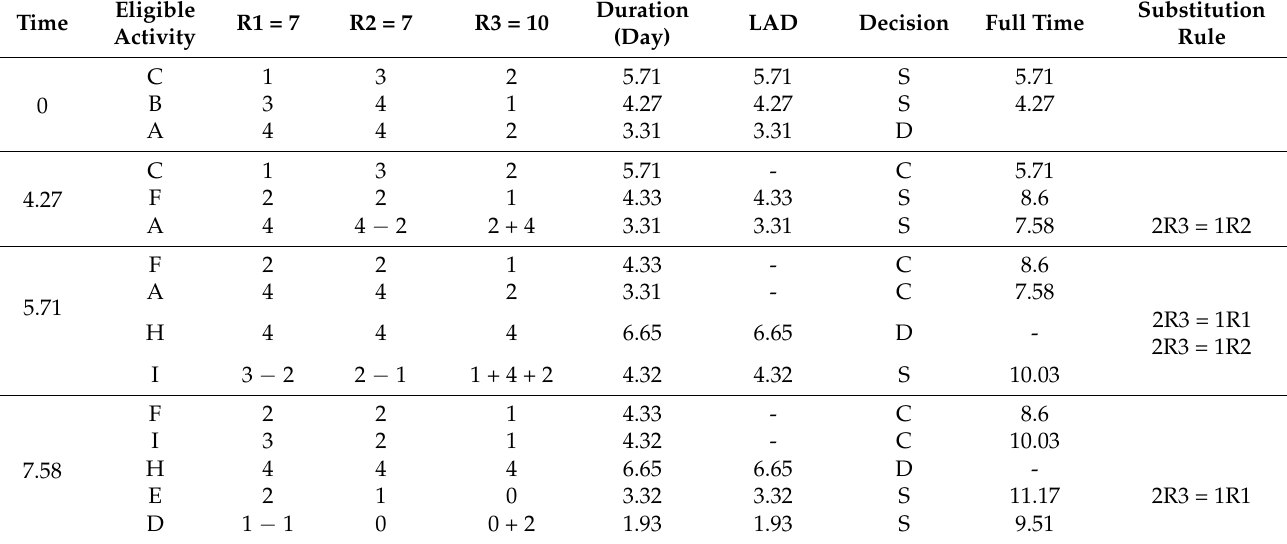
Table 5. Stochastic multi-skilled resource schedule (SMSRS) for Project